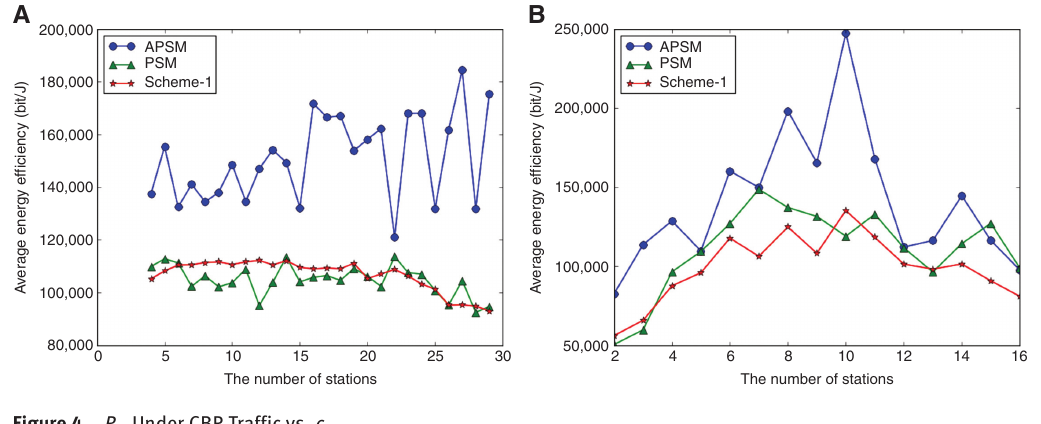
Under CBR Traffic vs. c Figure 4. R ee